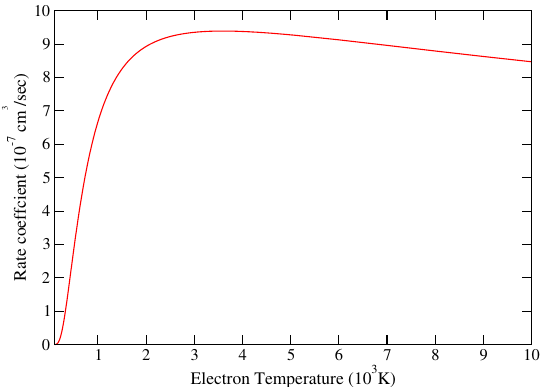
Figure 6. Elastic rate coefficients in the 12-states CC